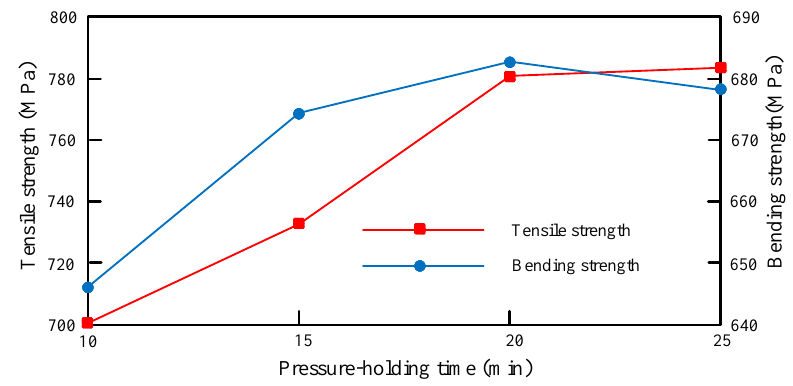
Figure 9. Mapping relationship between pressure-holding time and mechanical properties.